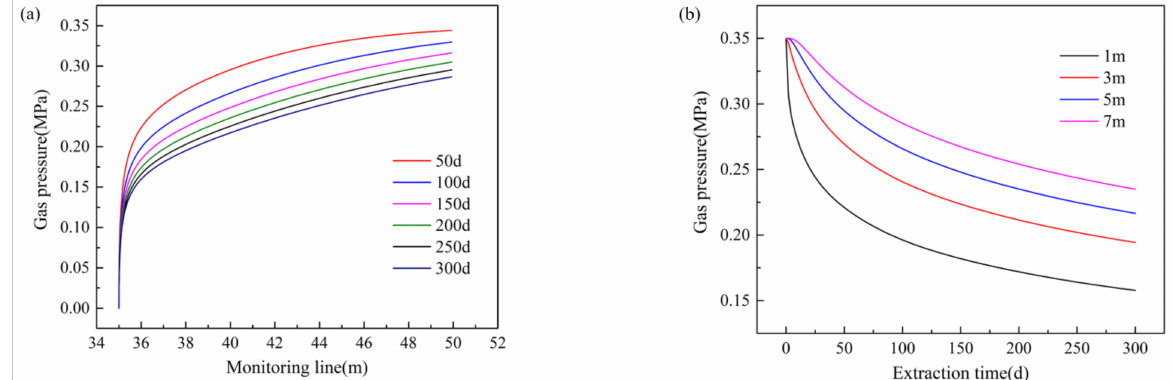
Figure 15. Monitoring data of gas pressure of monitoring line and monitoring points. ( a ) Variation law of gas pressure with monitoring line at different drainage times. ( b ) Variation of gas pressure with time at different distances from borehole.